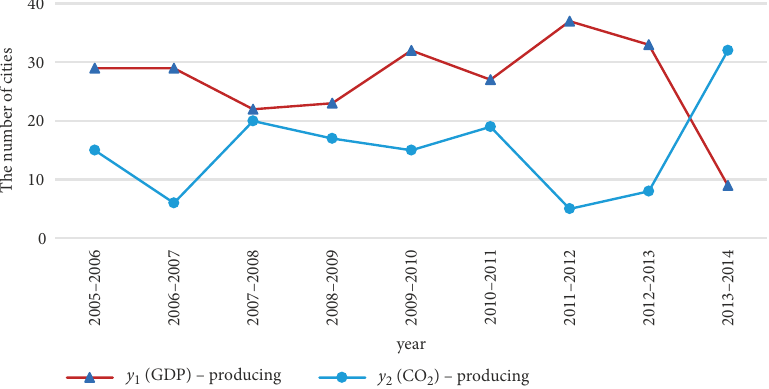
Figure 10. Output biased technological changes of GDP ( y 1 ) and CO 2 ( y 2 )